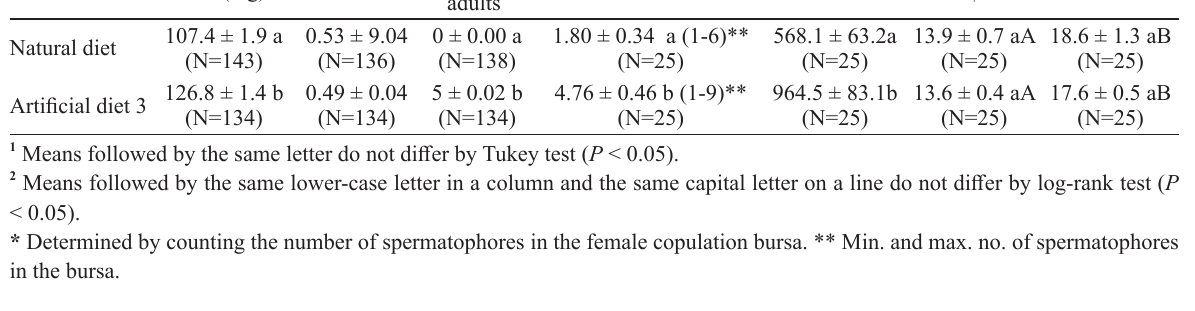
Female pupal weight, sex ratio, number of deformed adults, mean number of copulations, fertility, and lifespan of females and males of Condylorrhiza vestigialis reared on natural and artificial diets. Treatments